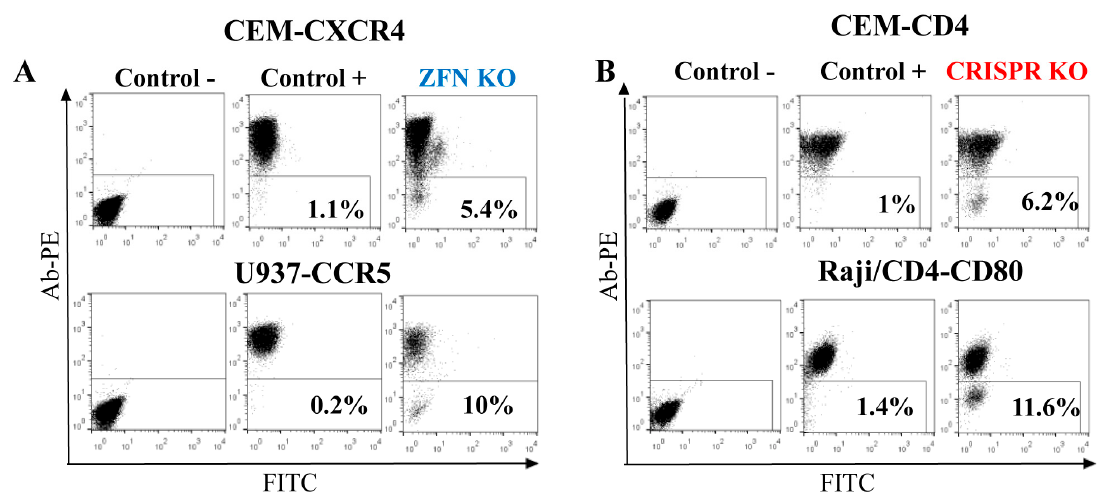
Figure 4. Efficiency of gene KO with ZFN ( A ) and CRISPR/Cas9 ( B ) in lymphoid and myeloid cell lines. Indicated cell lines were transfected with either ZFN expression plasmid DNA or two juxtaposed sgRNAs plus Cas9n expression vector DNAs. After a week, cells were surface-stained with corresponding primary mAbs and secondary anti-mouse PE-labeled Ab, and analyzed by flow cytometry. As a negative control, the primary mAb was omitted. As a positive control, immunostained non-transfected parental cells were used. Typical flow cytometry dot plots are shown.